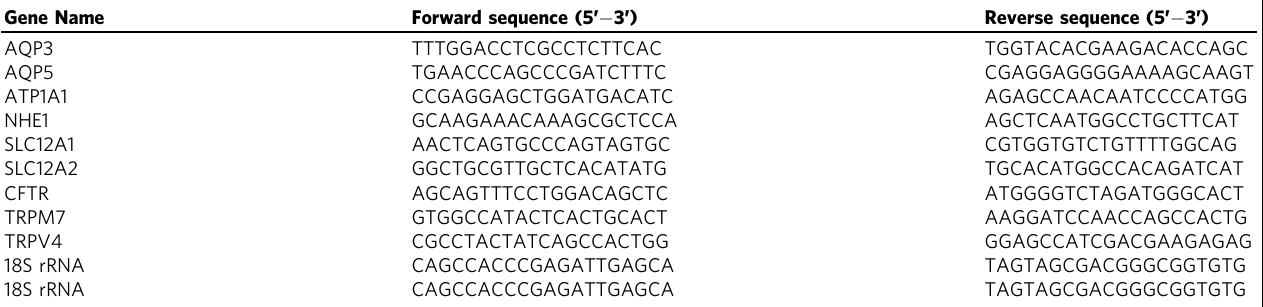
Table 2 Forward and reverse sequences of primers for the genes used for gene expression analysis in mouse cells. Gene